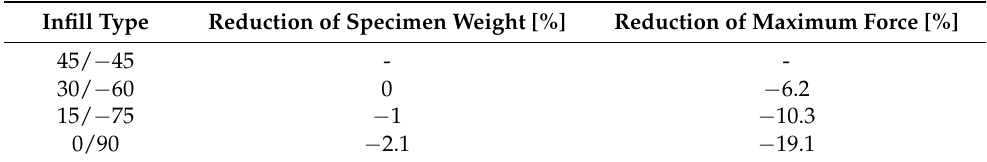
Table 7. Influence of infill orientation on specimen weight.